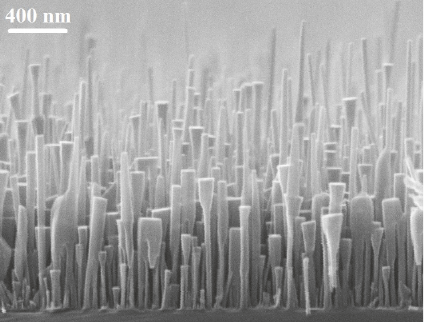
Figure 3: SEM images of InN NWs grown on SiC/Si(111) substrate.